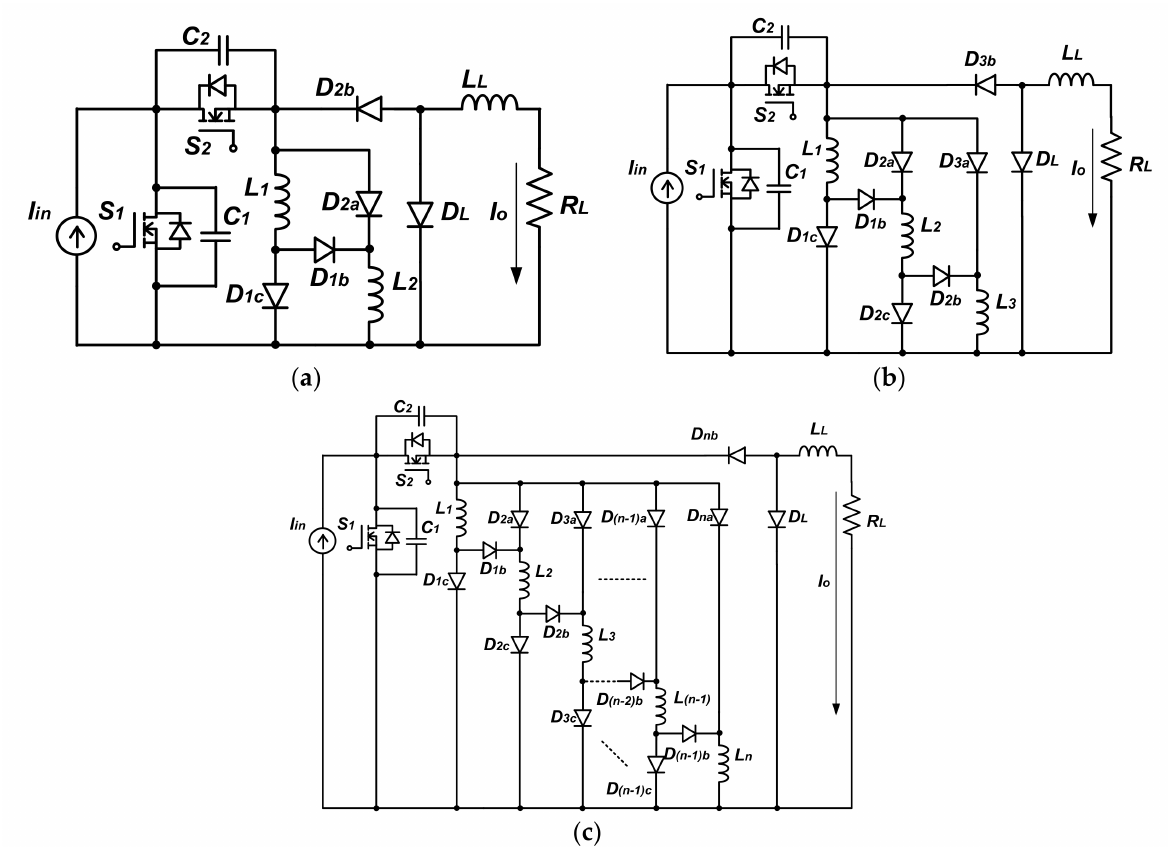
Figure 5. Inverting step down resonant switched-inductor converters; ( a ) − 1/2-type, ( b ) − 1/3-type, ( c ) − 1/ n